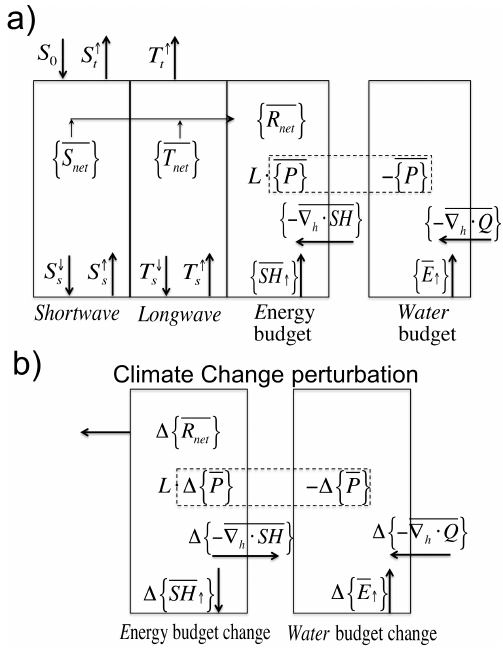
Fig. 3. Schematic diagram showing notation for the (a) the atmospheric energy and water budgets and (b) perturbation of atmospheric energy and water budgets following climate-change related precipitation increase. For both energy and water, the terms of the budgets (and budget changes) are displayed so that they sum to zero following Eqs. (3), (4), (9) and (10). Rightmost boxes show the atmospheric water budget while the boxes on the left show the corresponding energy budgets. In (a) from left to right, the three boxes on the left show atmospheric shortwave, longwave and total energy budgets. S and T denote shortwave and longwave radiative fluxes, respectively, with arrows indicating upward or downward direction. Subscripts s , t and o stand for surface, top of the atmosphere and solar constant, respectively. R net is the net radiative flux as the sum of net longwave ( T net ) and shortwave ( S net )